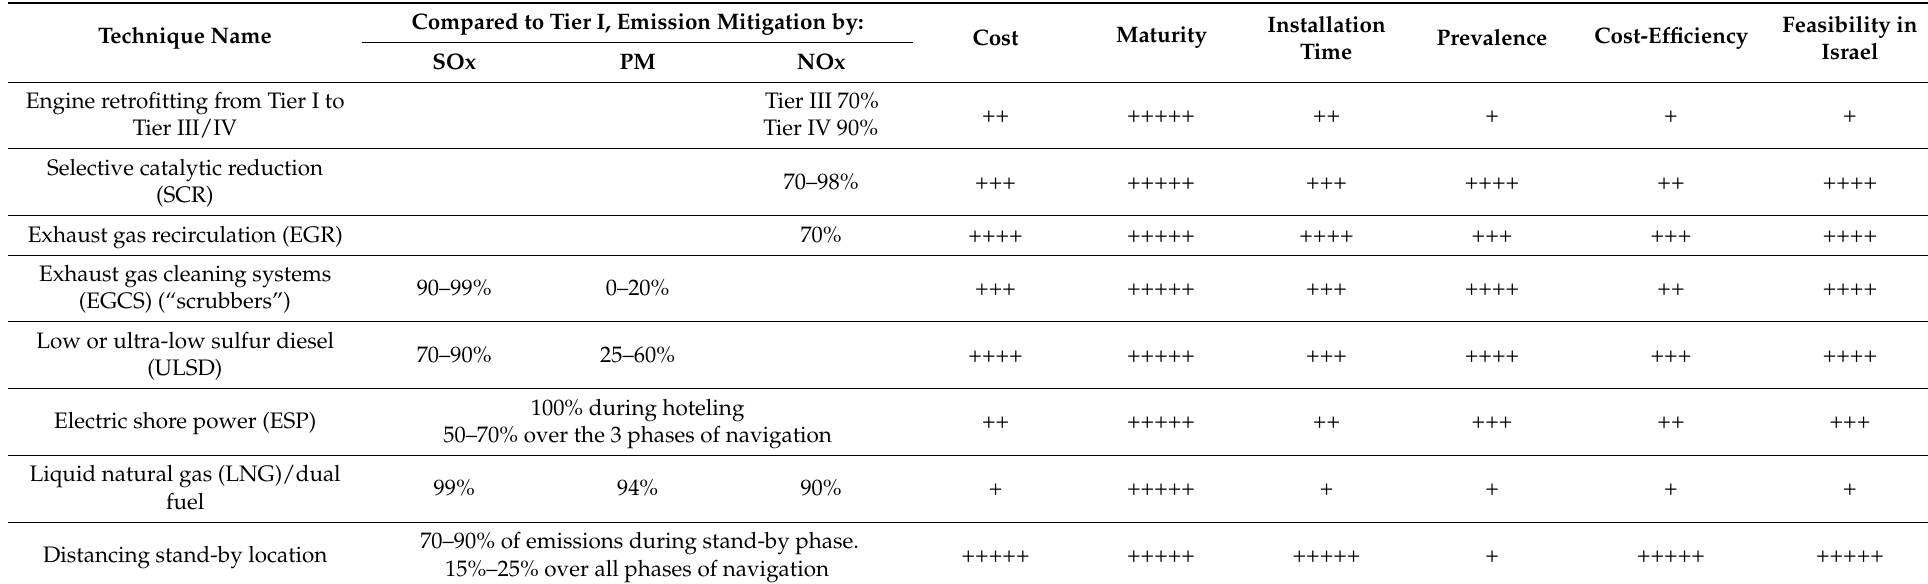
Table 1. Marine air pollution mitigation techniques and their feasibility in